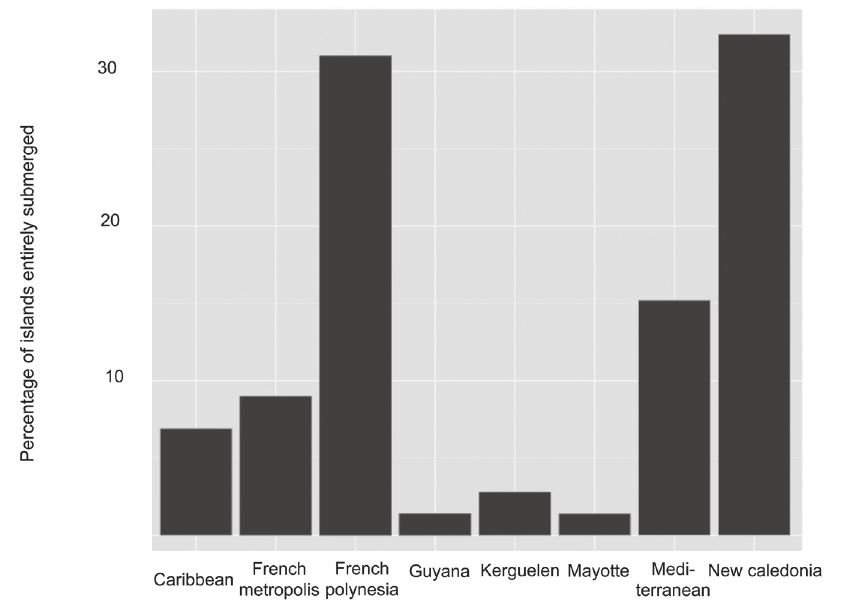
Figure 3. Spatial distribution of the entirely submerged islands for the different French regions under an increase of sea level by 3